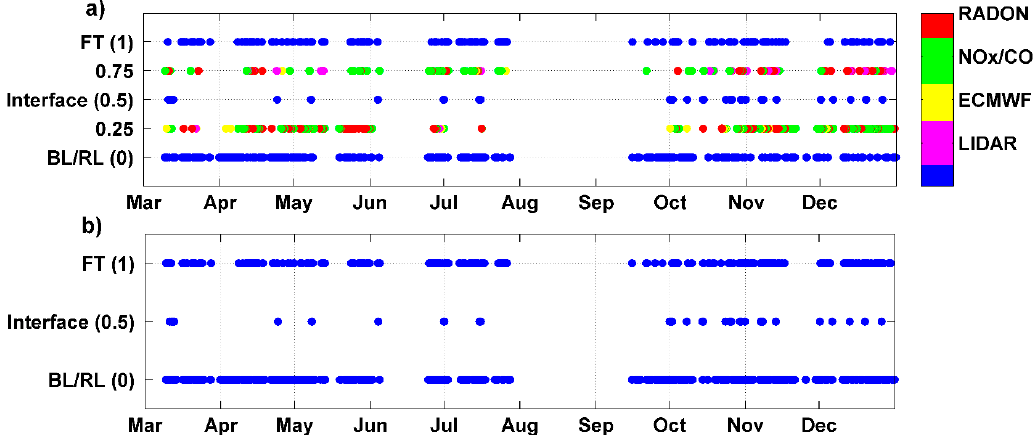
Figure 5. The combined classification of the four methods for the year 2015. ( a ) 1: All four methods classified the air mass to be within the FT, 0.75: three out of four methods classified the air mass as being within the FT, 0.5: only two out of four methods classified the air mass as being in the FT, 0.25: Three out of four methods classified the air mass as being within the BL/RL and 0: all four methods considered that the air mass was within the BL/RL. Color bar indicates where the method failed in calculating the FT(1)/(BL/RL)(0) conditions. Violet: LIDAR, yellow: ECMWF, Green: NO x /CO, Red: Radon-222 and Blue: successful or equality in the calculation of the FT/(BL/RL) conditions. ( b ) Same as (a) with 0.25 and 0.75 combined with 0 and 1, respectively.